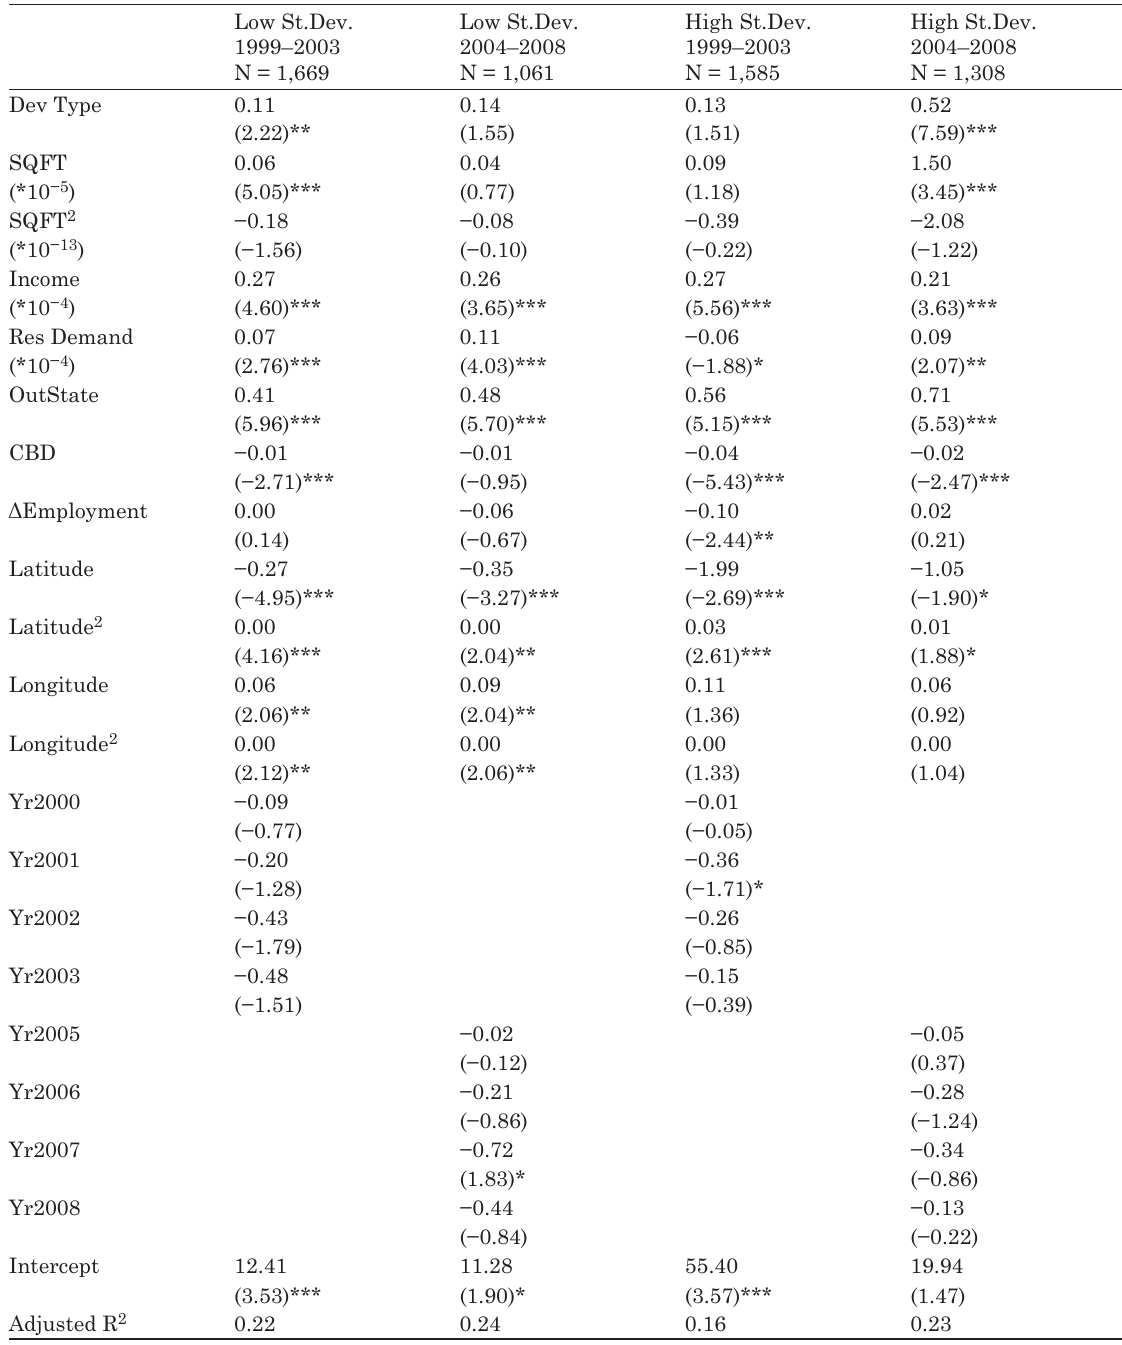
table 5. The table reports coefficients and heteroscedasity-consistent t-statistics (in parentheses) of subsamples split by the standard deviation of the natural logarithm of transaction prices (the dependent variable) as well as two time periods. YR1999 is the base year for 1999-2003 sample while YR2004 is the base for 2004-2008 Low